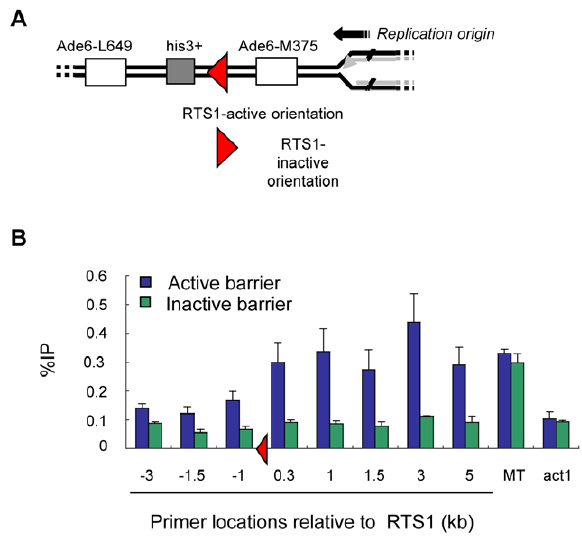
Figure 4. c H2A forms at an ectopic RTS1 replication fork barrier. (A) Diagram illustrates position of RTS1 barrier located between two direct repeats of Ade6 alleles. Diagram based on [49]. (B) c H2A ChIP at sites surrounding the active or inactive RTS1 fork barrier. ChIP was performed on asynchronous cultures. A primer –3 kb from the RTS1 barrier in the MT locus was used as positive control.